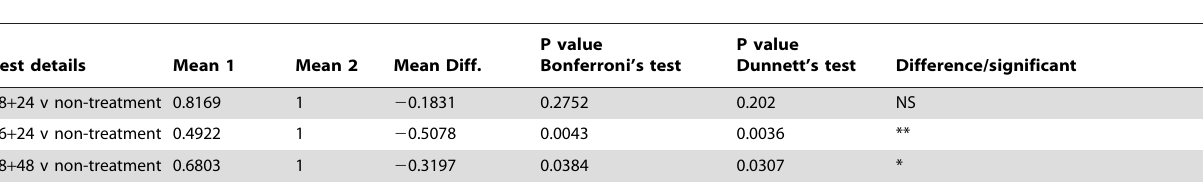
Table 3. Statistical comparisons (ANOVA) for PrP levels in flies treated with combinations of 17 DMAG and